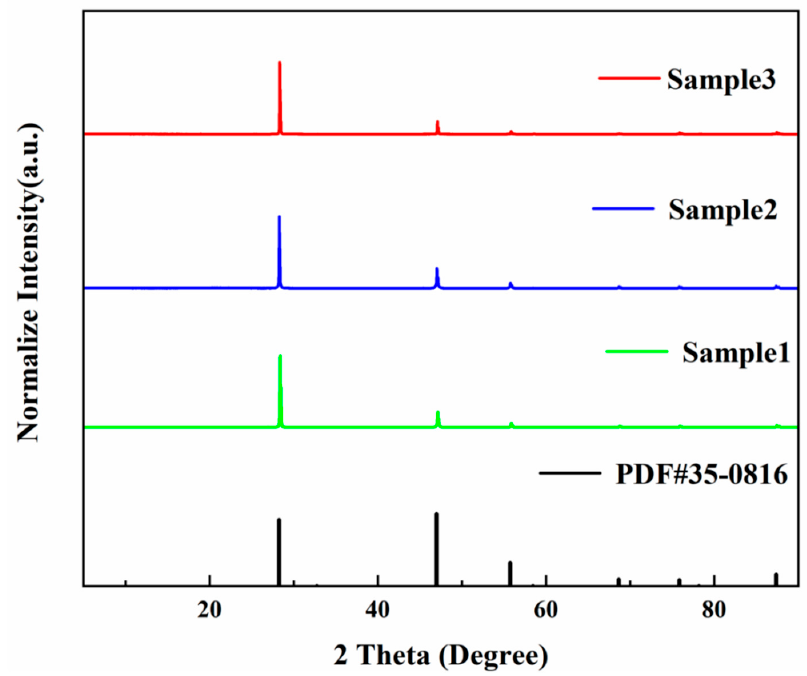
Figure 3. XRD patterns of the three samples and standard data of fluorite (JCPDS No. 35-0816). Table 1. The cell parameters, cell volume, and fitting degree of the three samples.